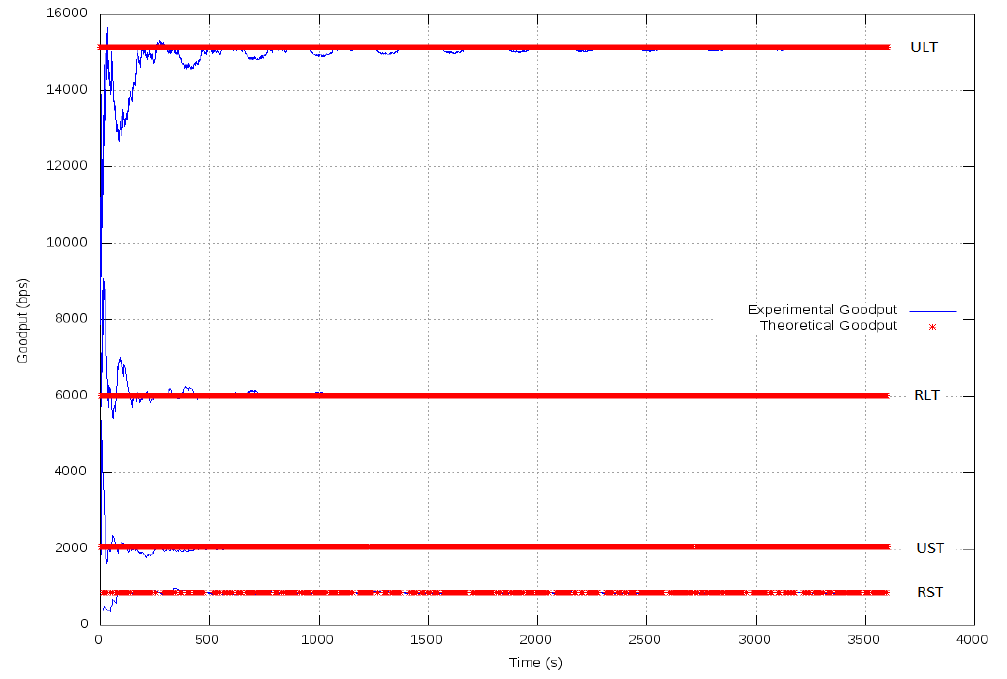
Figure 14. NAN results for each scenario for a simulation time of 3600